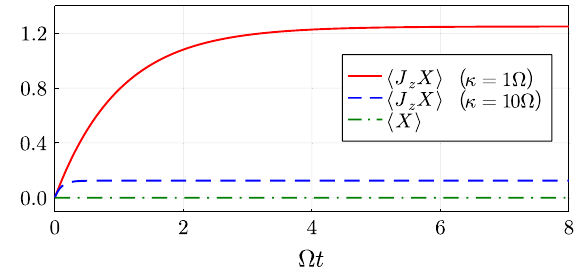
FIG. 5. Time-dependent behavior of the correlations (cid:3) J z X (cid:2) for two different values of the cavity loss rate κ = (cid:13) (solid red line) and 10 (cid:13) (dashed blue line)—respectively corresponding to the good and bad cavity regimes—and of (cid:3) X (cid:2) (dash-dot green line) for both values of κ . While the quadrature (cid:3) X (cid:2) remains zero for all times in both regimes, correlations between the atoms and the cavity mode build up. The smaller κ , the larger the